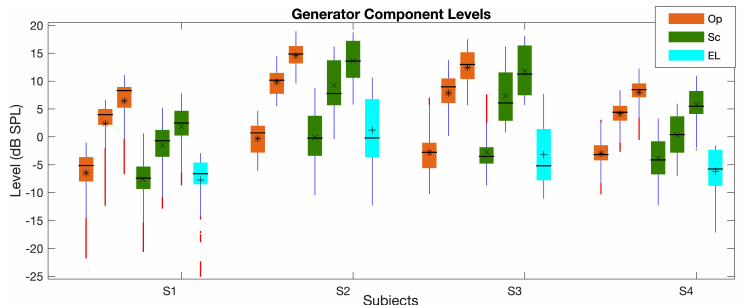
Figure 1. Boxplot of the L gen averaged at low, mid, and high L 2 s (three orange and green bars show the Op and Sc paradigms, respectively; the cyan bars show the mid-level values in the EL paradigm) across frequency. The central horizontal line, and the bottom and top edges of the boxes indicate the median, 25th and 75th percentiles, respectively. The averages of individual bars are indicated by the ∗ , × , + symbols (for the Op, Sc, and EL paradigms, respectively) inside the boxes. The whiskers extend to the most extreme data points and outliers are plotted using red dots. The subjects’ IDs (S1–S4) are indicated on the x-axis.